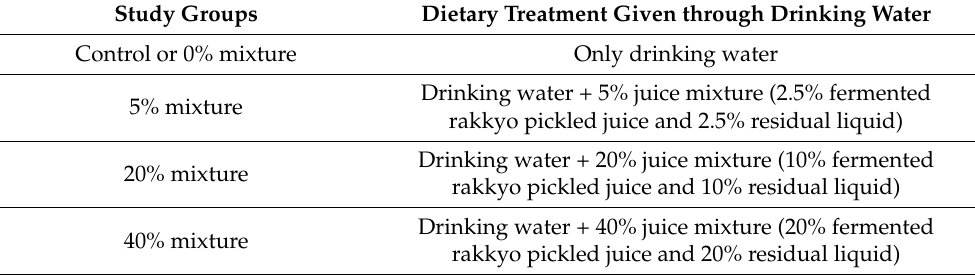
Table 1. Study groups and dietary treatments used for the in vivo trial. Study